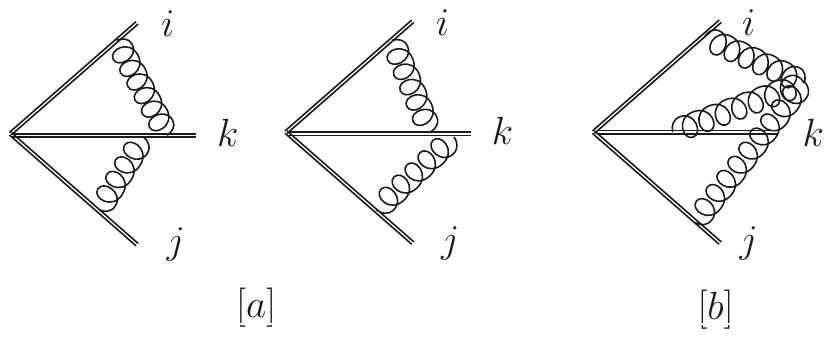
Figure 3 . Double-virtual diagrams involving three eikonal lines i and j